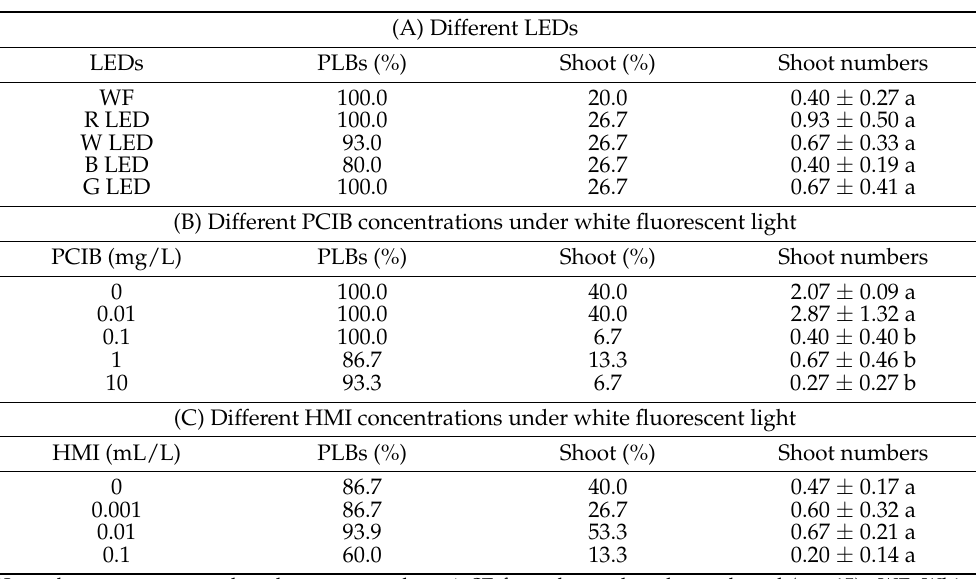
(C) Different HMI concentrations under white fluorescent light